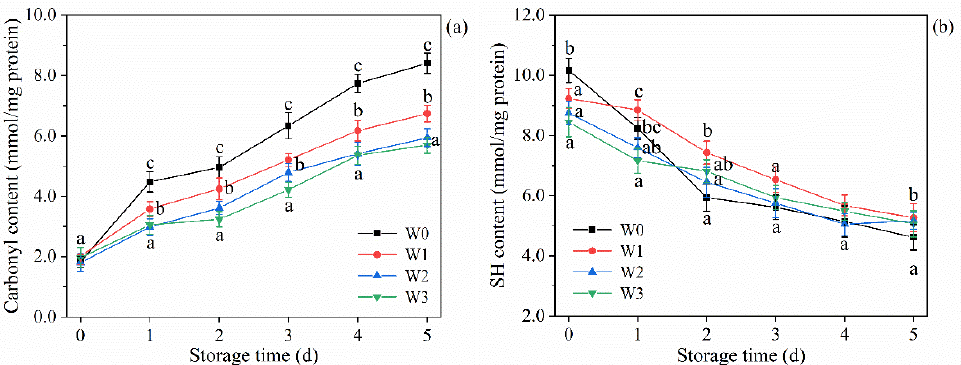
Figure 4. Changes of surimi with different washing times on the carbonyl group ( a ) and SH content ( b ) during 4 °C refrigeration. Different letters denote the significant difference ( p < 0.05).